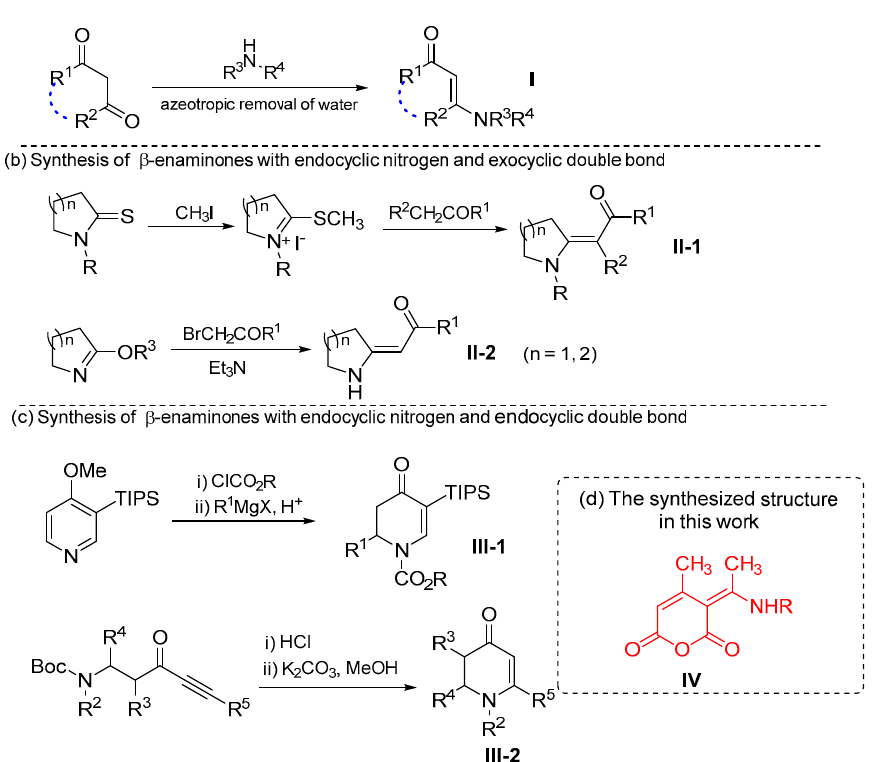
Figure 1. Synthetic pathways to different typical β -enaminones ( a [13–16], b [13,14], and c [17–19]) and the synthesized structure ( IV ) in present work.